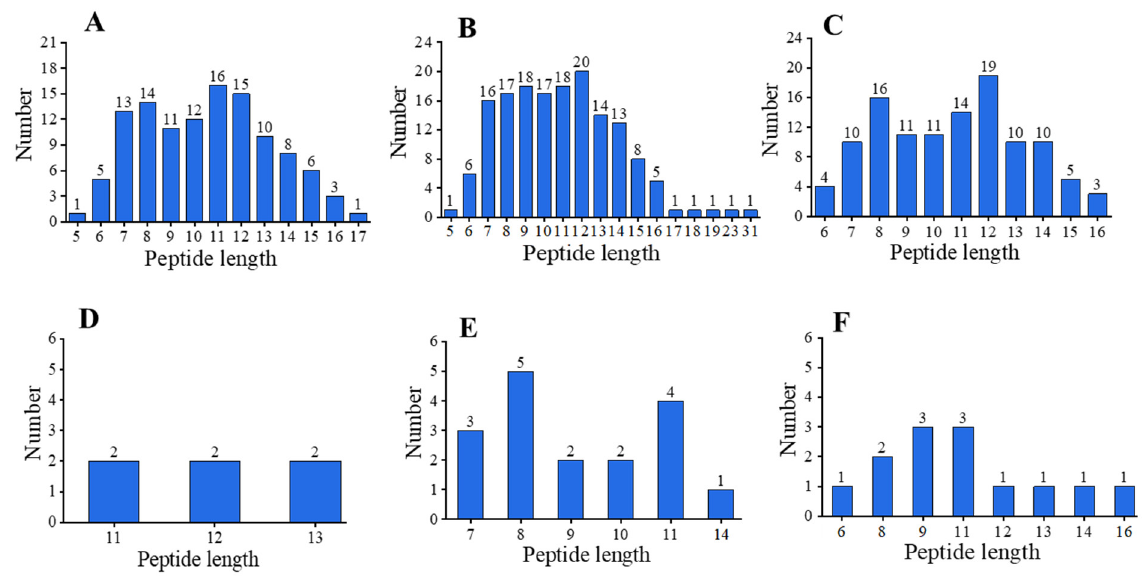
Figure 5. Detectable peptide profiles in the digests of bLf ( A , D ), LfPF complex ( B , E ), and LfPFTG complex ( C , F ) after in vitro gastric (pepsin) digestion ( A , B , C ) and gastrointestinal (pepsin + trypsin) digestion ( D , E , F ).